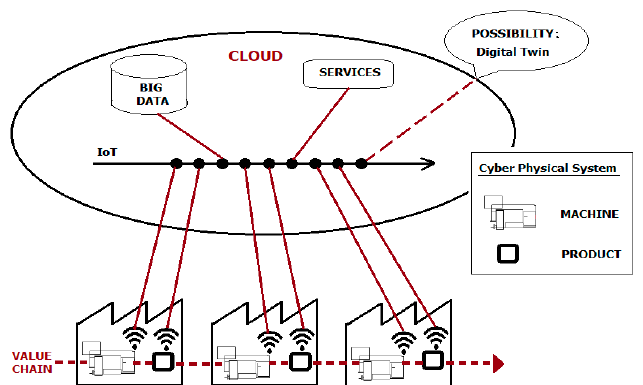
Figure 1. Integration of Industry 4.0 technology with possible Digital Twin utilization (Own processing [13]).